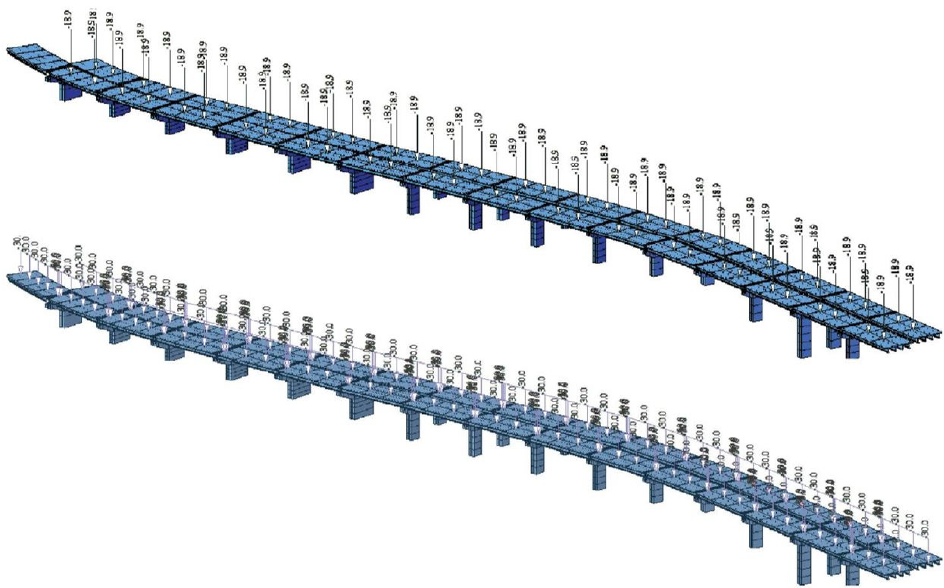
Figure 11. Nodal loads from non ‐ structural elements ( upper ) and pavement linear loads ( lower ). To summarize, the RC sections of the bridge (i.e., piles, piers, pre ‐ stressed beams, and deck) were modelled solely with beam finite elements. The neoprene bearing elements of the beams on the piers were modelled with “general ‐ link” elements in MidasGen, where the stiffness matrix elements which were calculated with reference to the simplified UNI 1337 ‐ 3 method were manually inserted. The deck was modelled with a single beam ele ‐ ment, and the section imported from SPC is shown in Figure 10a. To simulate the actual support of the prestressed RC beams on their respective neoprene bearings, “rigid ‐ link” elements were used to account for the vertical eccentricity.